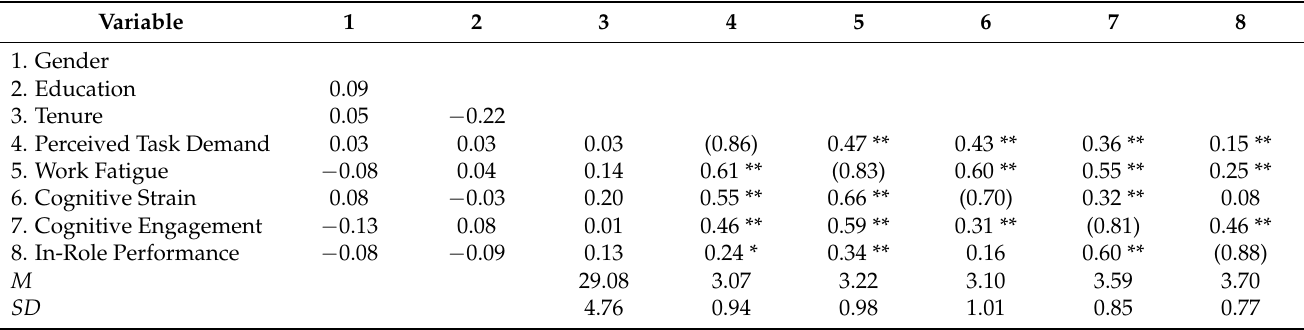
Table 2 provides the descriptive statistics, intra-correlations, and correlations for the study variables. The results preliminarily verified the hypotheses. Table 2. Mean, standard deviation, and correlations of